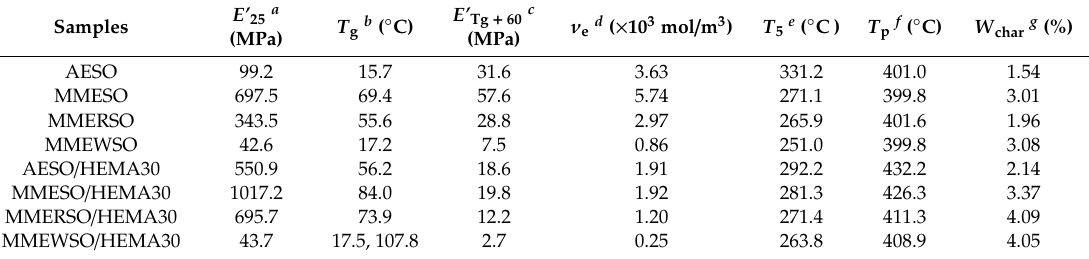
Figure 3. Storage modulus ( a,b ) and loss factor( c,d ) of the UV-cured EA-like materials. Table 3. Dynamic Mechanical Analysis (DMA) and Thermogravimetric Analysis (TGA) results of the UV-cured EA-like